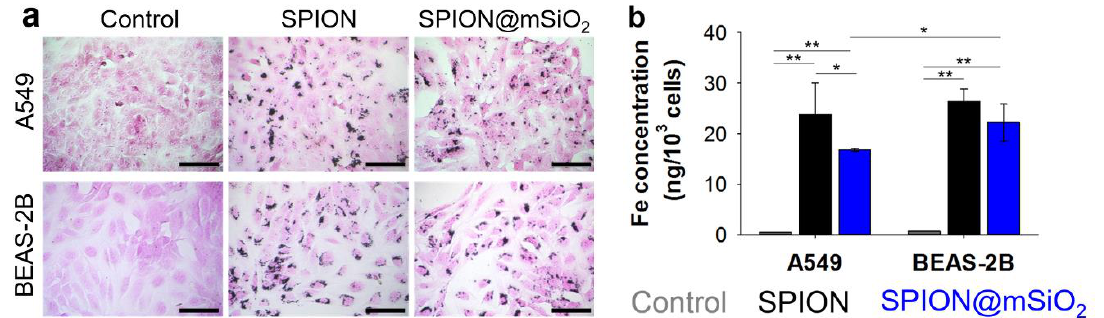
Figure 5. Prussian blue and eosin staining of A549 and BEAS-2B cells incubated with SPIONs or SPION@mSiO2 for 24 h. Scale bar = 100 μm ( a ) and concentration of Fe in the cells ( b ). Statistically significant differences at * p < 0.05 and ** p < 0.001.